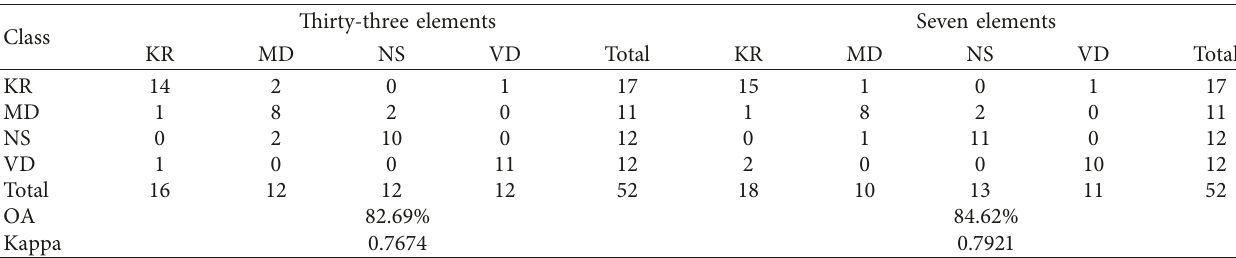
Figure 8: The importance of optimum variables selected by GRRF calculated by the ordinary RF algorithm. The highest mean decrease in the Gini index shows the most important variable. Table 5: Error matrices showing the overall accuracy and kappa for the classification of the four soil classes, nonvitrified dung (NVD), midden (MD), nonsites (NS), and vitrified dung (VD), using all variables (33 elements) and the optimum variables (7 elements).